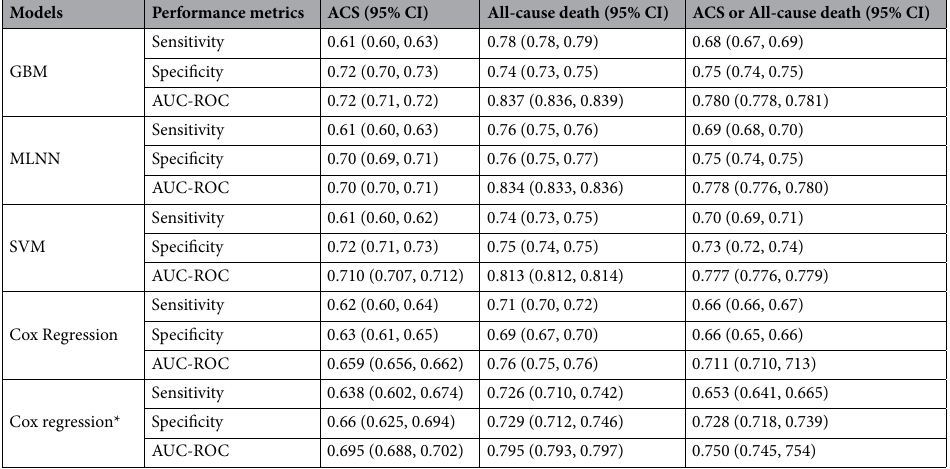
Table 2. Performance of machine learning models and Cox regression measured by sensitivity, specificity, and AUC-ROC. *Cox model with binary variables.